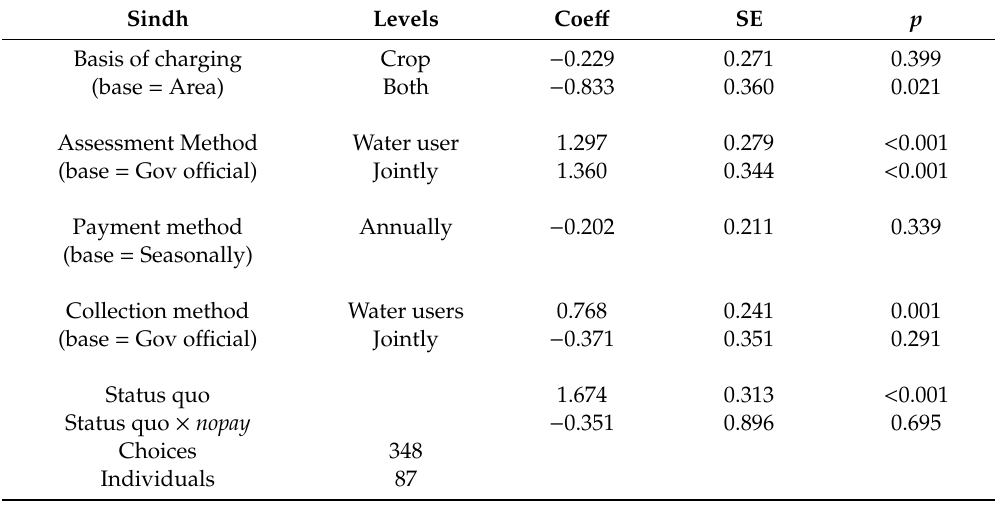
Table 9. Conditional logit estimates for preferences for irrigation payment systems: Sindh.